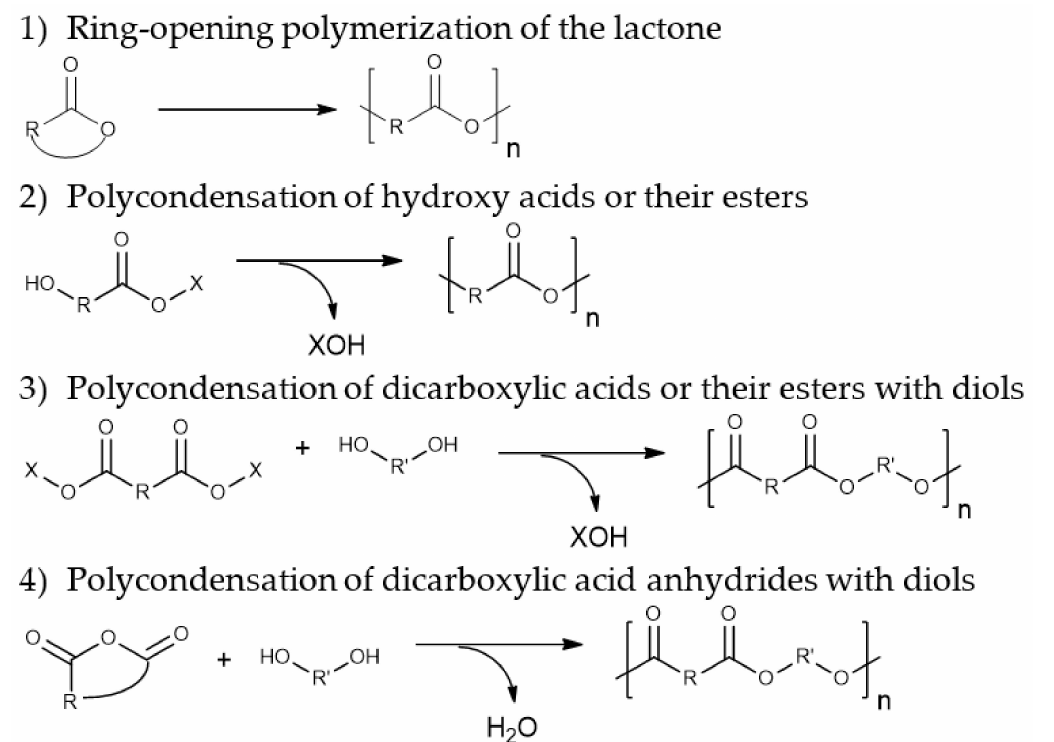
Figure 7. Methods for obtaining polyesters. R, R (cid:48) —substituents in the molecules of dicarboxylic acid and diol; X—H, Me,